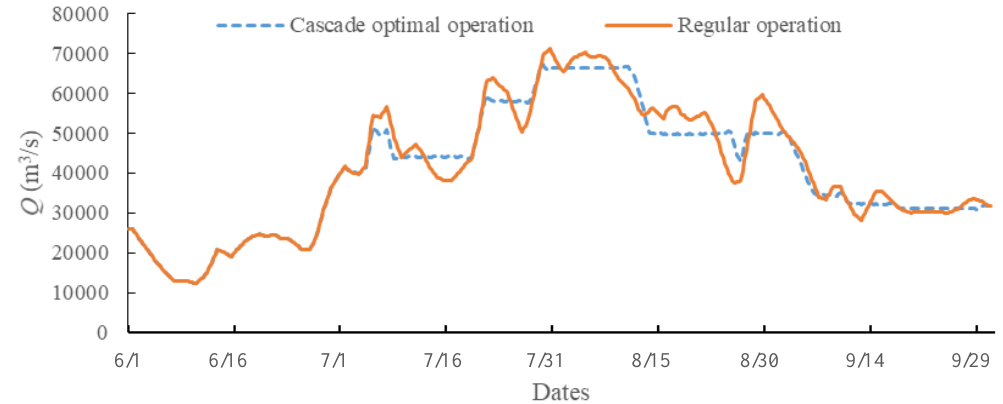
Figure 8. Inflow of TGR obtained by the two operation models for the 1000-year DHF amplified by the 1954 TFH.